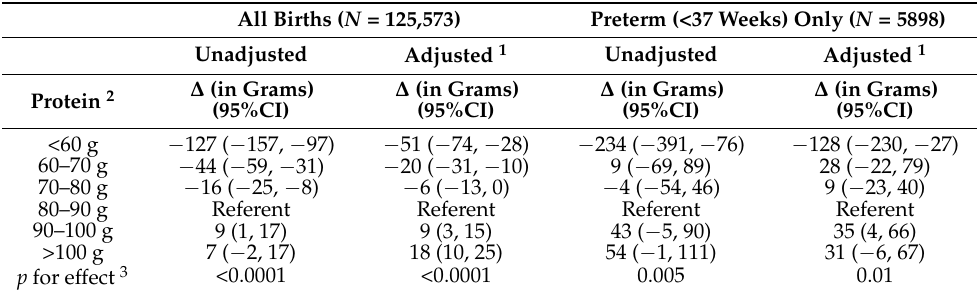
<0.0001 ∆ : mean difference in birth weight in grams per day compared to the reference. 1 Adjusted for cohort, maternal age, parity, maternal smoking, pre-pregnancy body mass index, height, education, marital status, total energy